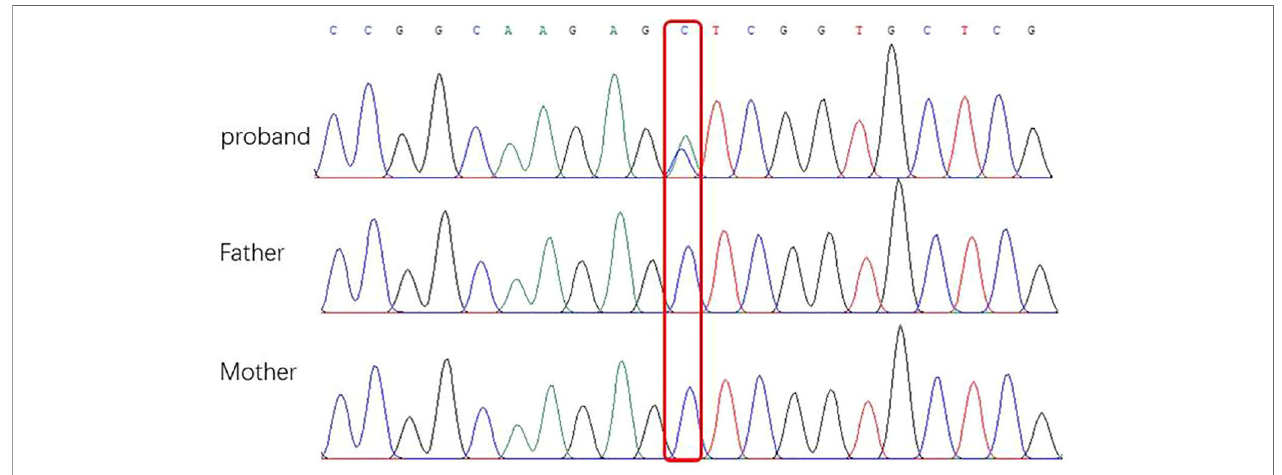
FIGURE 5 | Sequencing of DNM1 gene mutations of children and their parents in this study. (A) Base 135 of the coding sequence of the DNA of a patient in this group shows a missense mutation c.135C > A (p.GluS45R) (arrow). (B) and (C) are the corresponding gene sites in the father and mother, respectively; these sites (arrow) do not show the